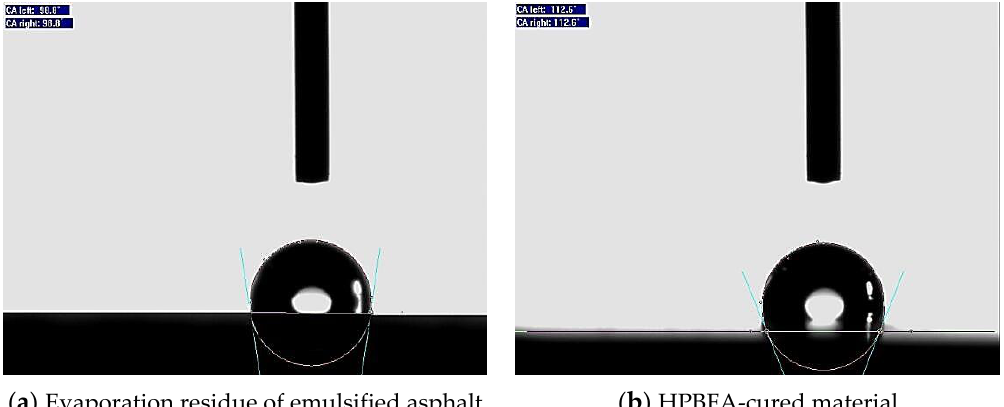
Figure 16. Contact angle of the cured material.